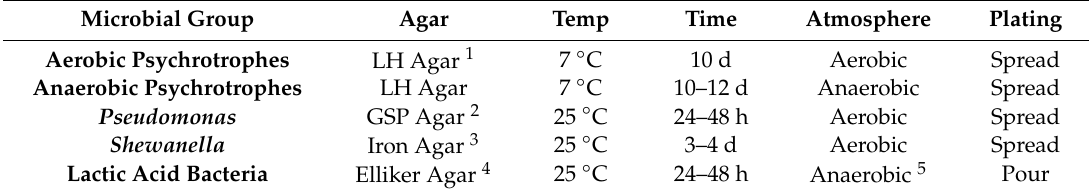
Table 2. Recovery conditions for the di ff erent microbial groups